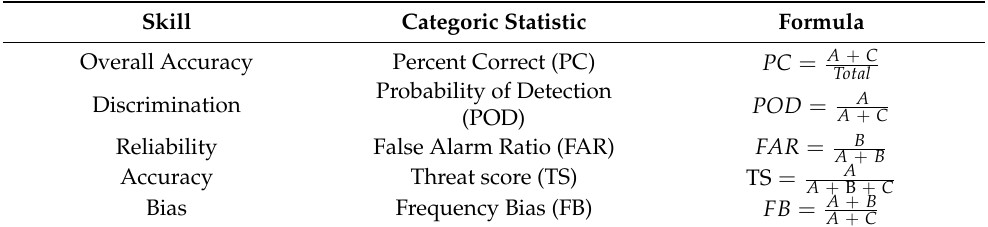
Table 3. The formulas of categorical statistics used in analyzing the detection skill of CHIRPS estimates (based on ref. [46]). Skill Categoric Statistic Formula Overall Accuracy